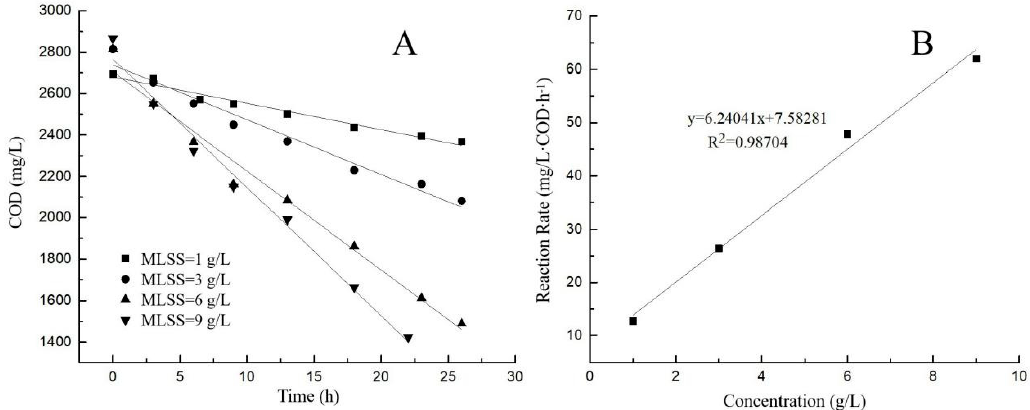
Figure 3. ( A ) COD changes with different MLSS contents using linear fitting; ( B ) COD degradation rates with different MLSS contents.